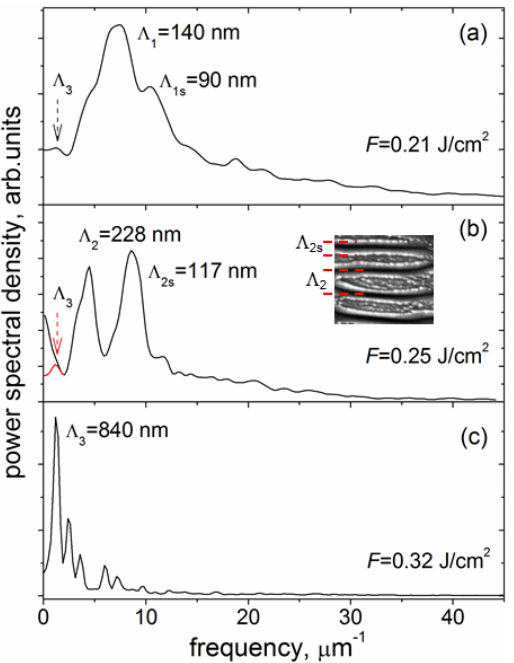
Figure 6. 1D-FFT spectra ( a – c ) characterizing the periodical nanorelief in the direction perpendicular to the ripples of the SEM images shown in Figure 2d–f; the Λ 3 peak (marked in red) in ( b ) is a result of the FFT spectrum decomposition in the frequency range of 0–2 µ m − 1 ; an inset in ( b ) illustrates that the appearance of the Λ 2s peak is due to high-brightness edges of thin layers formed by spallation.